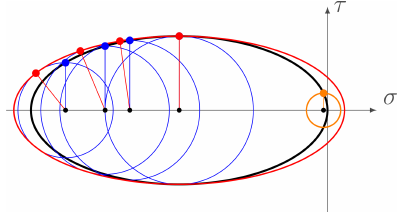
Figure B1. Illustration of the Mohr’s circle applied to the elliptical yield curve (black ellipse) in σ , τ space, some examples of Mohr’s circles (blue), and the reconstructed yield curve (red) in the fracture plane space. The orange Mohr’s circle illustrates the case in which no fracture lines exists, for | µ | > 1.